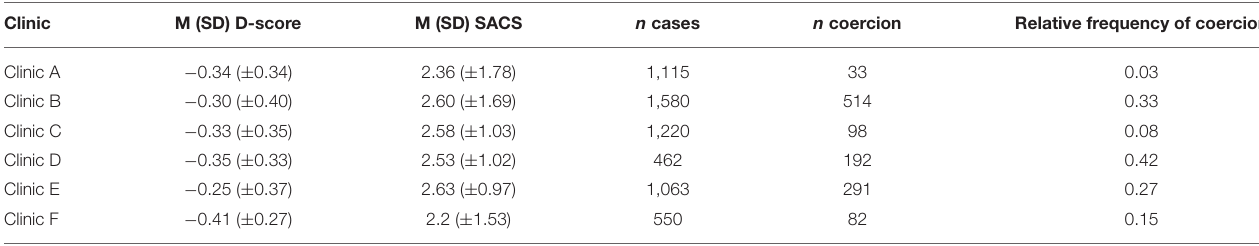
TABLE 1 | Descriptive statistics for D-scores and SACS scores, the number of treated cases, the total number of coercive measures, and the relative frequency of coercion.